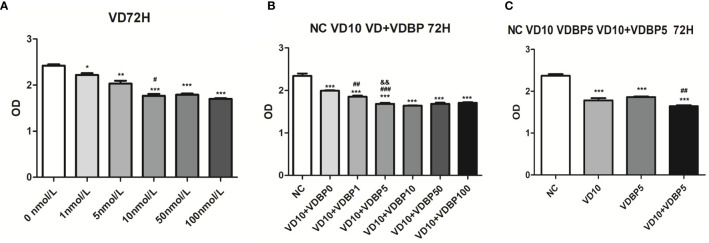
Effect of 1,25(OH)2D3, Vitamin D-binding protein (VDBP), and 1,25(OH)2D3+VDBP on RASF. (A) The effect of 1,25(OH)2D3 on the viability of rheumatoid arthritis synovial fibroblasts (RASF) cells. RASF cells were treated with different concentrations of 1,25(OH)2D3 (0,1,5,10,50,100 nmol/L) for 72 h. Cell viability was assessed with CCK-8 assay. Compared with 0 nmol/L, *P < 0.05, **P < 0.01, ***P < 0.001. Compared with 5 nmol/L, #P < 0.05. (B) The enhanced inhibition of 1,25(OH)2D3 with VDBP on the viability of RASF. RASF cells were treated with 1,25(OH)2D3+VDBP as indicated in the figure. Compared with NC, ***P<0.001. Compared with VD10+VDBP0, ##P < 0.01, ###P < 0.001. Compared with VD10+VDBP1, &&P<0.01. (C) The enhanced inhibition of 1,25(OH)2D3 with VDBP on the viability of RASF. RASF cells were treated with 1,25(OH)2D3, VDBP, and 1,25(OH)2D3+VDBP as indicated in the figure. Compared with NC, ***P < 0.001. Compared with VD10, ##P < 0.01.